Question: Provide a publication-style caption for this figure.
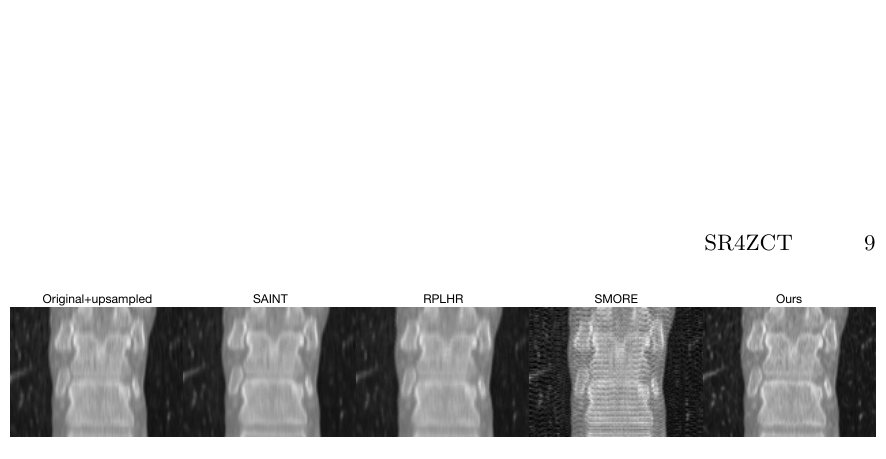
Answer: also demonstrates the importance of modeling the training images accurately. We applied supervised methods SAINT [14], RPLHR [19], and self- supervised SMORE [20], to Low Dose CT Grand Challenge [12]. We used the provided pre-trained weights for SAINT and trained RPLHR as described on their dataset. SAINT and RPLHR do not consider overlap in their method de- sign. For SMORE, we used convolution with a filter width of 4 and stride 3, which was equivalent to simulating 2.96mm resolution and 0.74mm overlap im- ages, the closest possible combination to the actual 3mm resolution and 1mm overlap. The blurriness caused by the overlap in the LR image was amplified in the results of SAINT and RPLHR, while artifacts occurred in the output of SMORE. In contrast, SR4ZCT improved the resolution and reduced blurriness